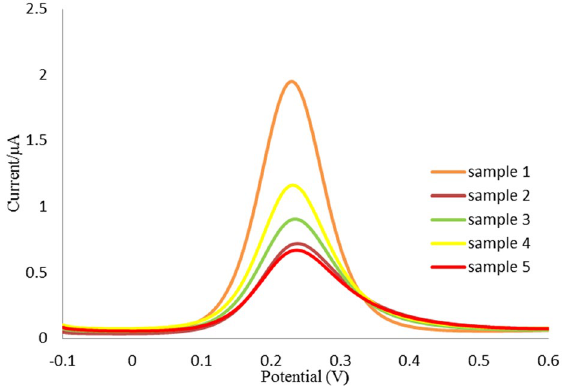
Figure 6. Real sample analysis of ROR1 biomarker in five clinical CLL human serum